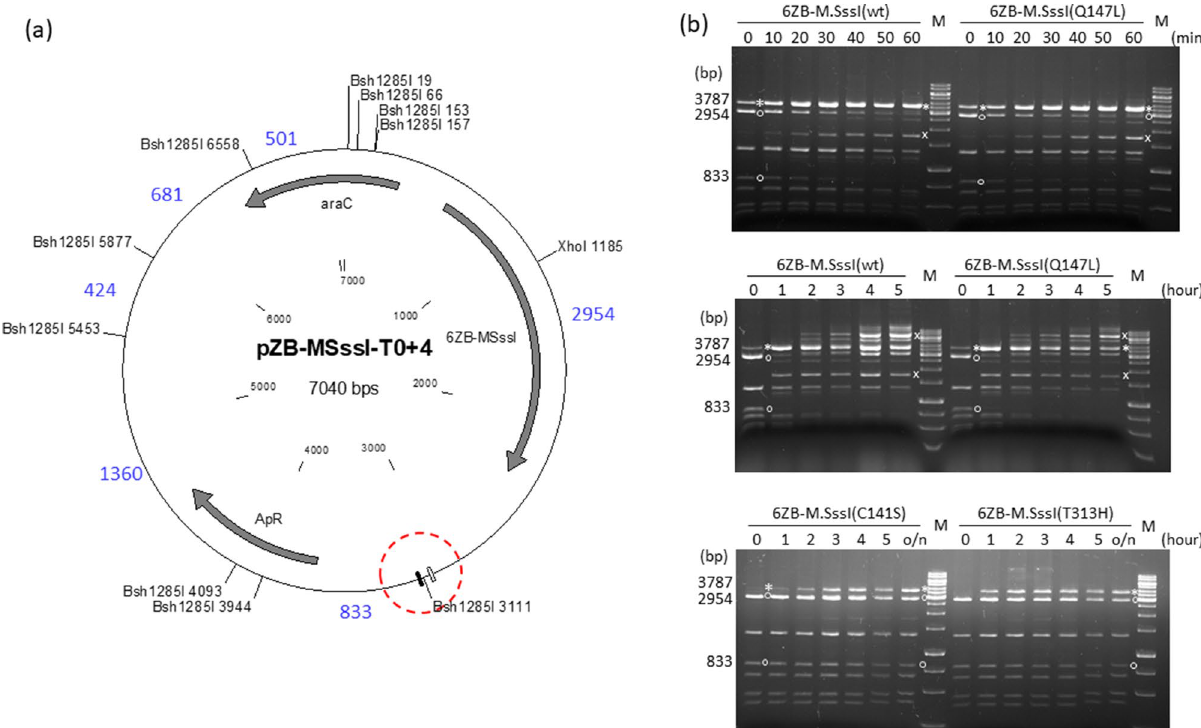
Figure 2. Targeted DNA methylation in E. coli by 6ZB-M.SssI variants. Cultures of E. coli ER1821 harboring pZB-MSssI-T0+4 (wild-type or mutant) were induced with arabinose for 6ZB-M.SssI expression. Plasmids prepared from the cultures were digested with Bsh1285I. ( a ) Map of pZB-MSssI-T0+4 (wild-type and mutant) with Bsh1285I sites. The 6ZA and 6ZB zinc finger binding sites are shown by open and closed boxes, respectively. The XhoI site is located between the 6ZB and M.SssI coding sequences. Red dashed circle, target region. Fragment sizes in base pairs are indicated with blue numbers. Methylation of the Bsh1285I 3111 site results in a 3787 bp (2954+833) protected fragment. ( b ) Time course of plasmid methylation. Plasmids were prepared after different lengths of arabinose induction as indicated above the lanes. The two parental fragments and the resulting protected fragment are marked with white circle and white asterisk, respectively. The fragment appearing first from off-target methylation is marked with white x. M, GeneRuler 1 kb DNA ladder (Thermo Scientific). Cropped gels. Full-length gels are presented in Supplementary Fig. S10. Quantitative analysis of the relative amounts of the parental and the protected fragments is shown in Supplementary Fig. S11. For biological replicates of the experiments of Fig. 2, see Supplementary Fig.